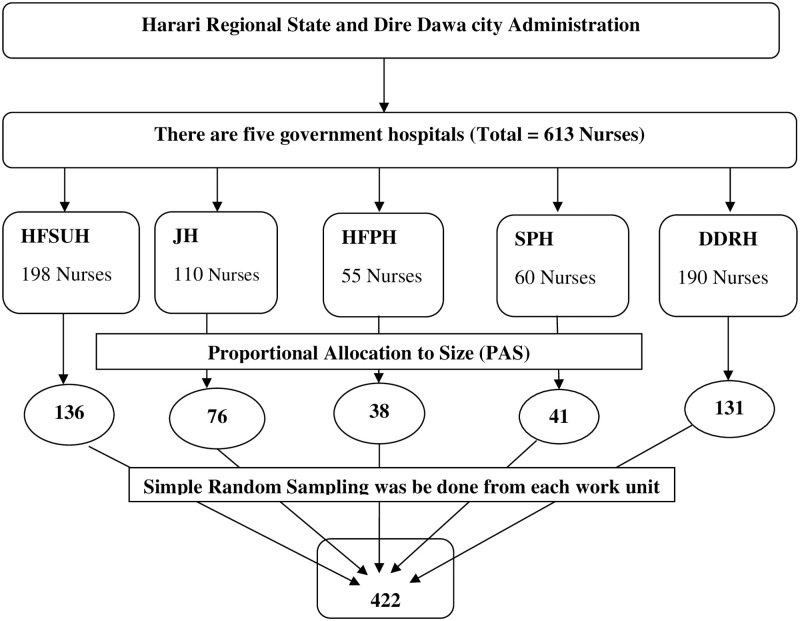
Schematic diagram of the sampling procedure for the study to assess pressure ulcer prevention practice and associated factors among nurses working in public hospitals of Eastern Ethiopia, 2018.